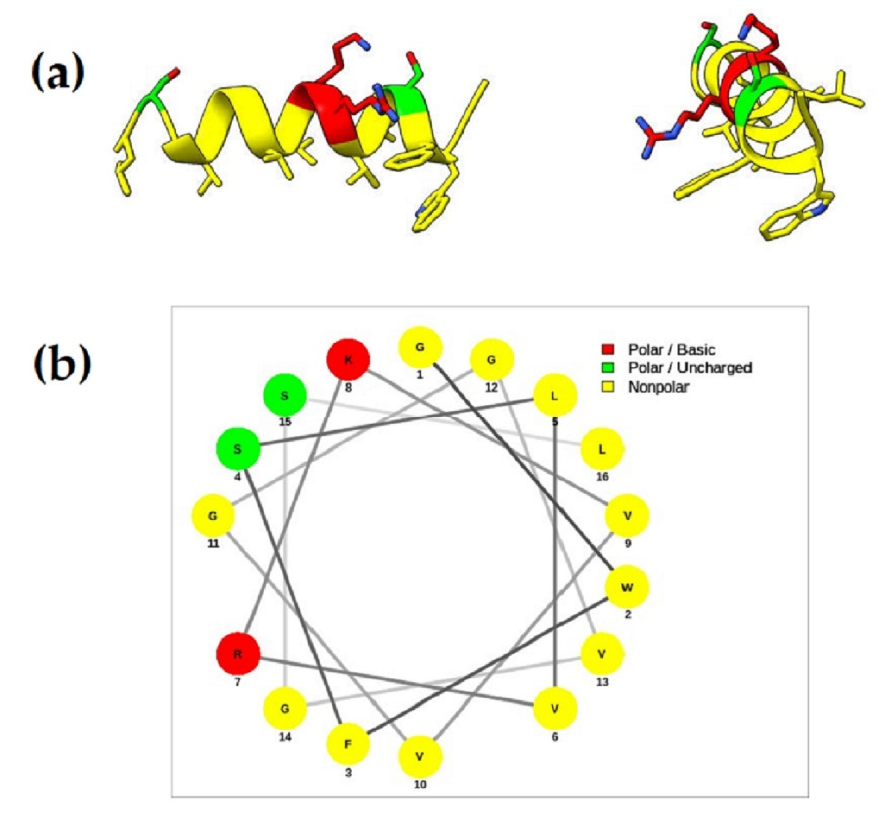
Figure 10. Ramosin peptide structure. ( a ) Tridimensional model obtained through I-TASSER server and built with Chimera X [54]. ( b ) Helical wheel representation. Positively charged polar amino acids are shown in red, uncharged polar amino acids in green, and nonpolar amino acids in yellow.